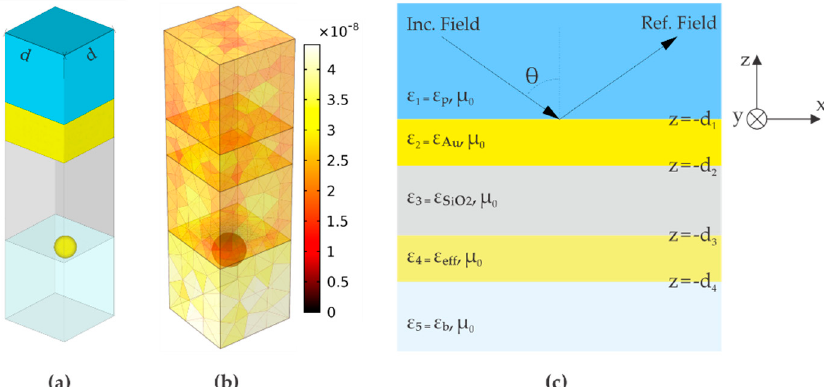
Figure 4. ( a ) Unit periodic cell considered in the numerical simulations by the COMSOL® software. The Floquet theorem is used to set the periodic boundary conditions. Periodic ports are used in the top boundary (set on to simulate the incident planar wave) and in the bottom boundary (set off to simulate a very large layer) [18]; ( b ) Mesh of the FEM model of the sensor. Colors indicate the size of the elements, which is defined by physical and geometrical factors; ( c ) Resultant planar structure of the PA-SPR sensor in the effective layer approximation to represent the AuNPs periodic array.